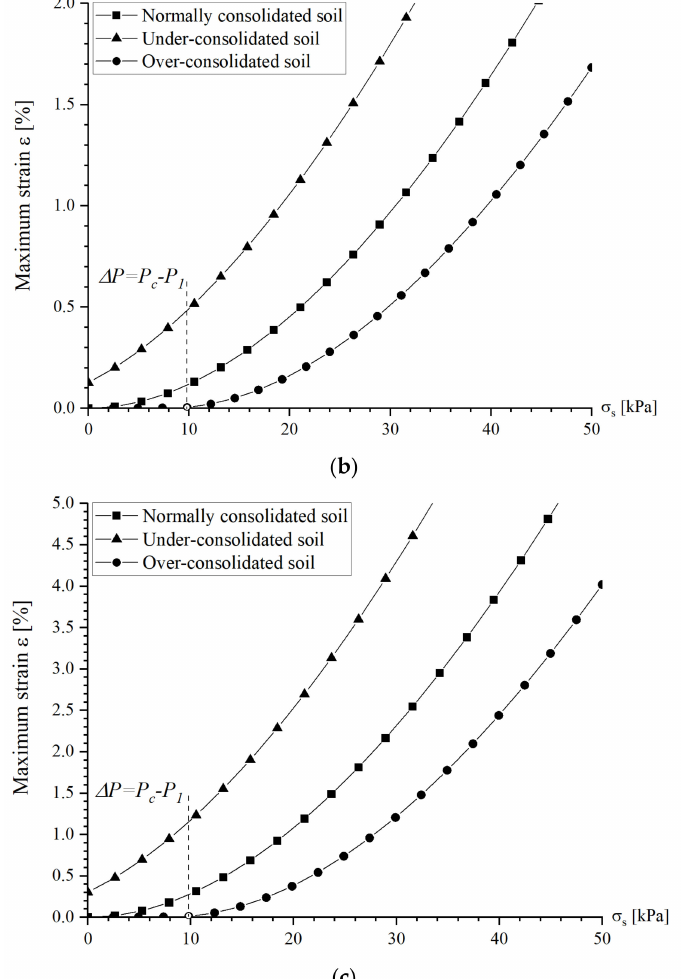
Figure 14. The maximum strain of the reinforcement under different stress histories; ( a ) Cc = 0.1;